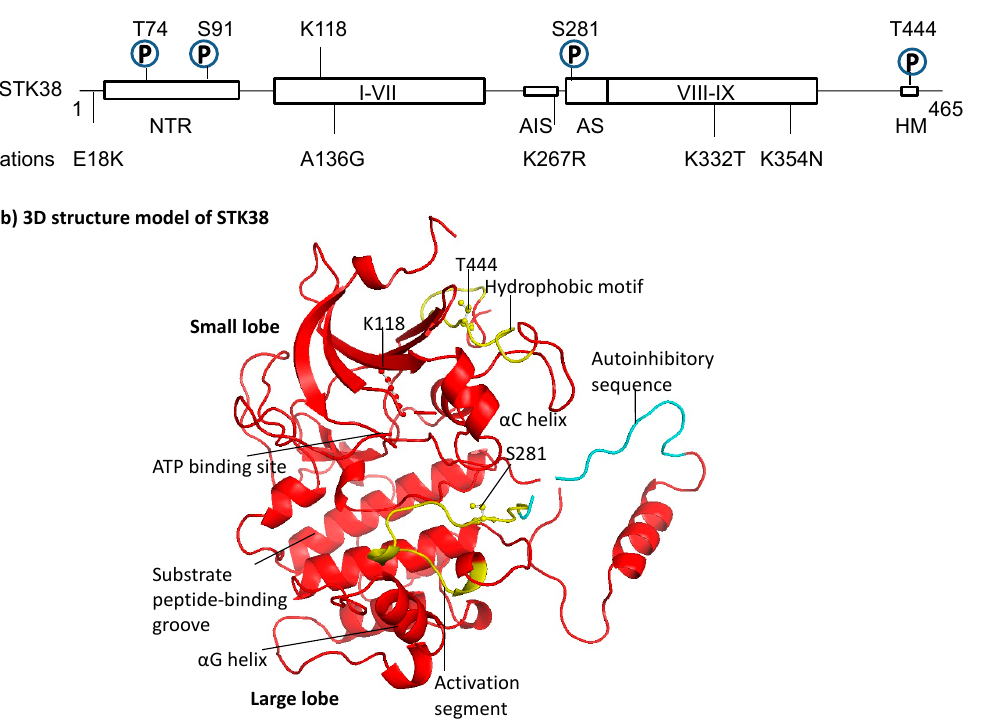
Figure 1. Most prominent three-dimensional structural features of STK38. ( a ) Domain structure of STK38. NTR at the N-terminus, subdomains I-VII, VIII-IX, activation segment (AS; aa277–292), and a hydrophobic motif (HM, aa439–451) at the C-terminus. Phosphorylation is denoted by P. The active center, a lysine residue, is located in subdomain II, and the autoinhibitory sequence (AIS, aa265–276) is situated between subdomains VII and VIII. Major somatic high-frequency mutations of STK38 in each cancer tissue are also described. Mutations in E18K are found in skin tumors, A136G in lung cancer, K332T and K354N in ovarian cancer, and K267R in normal tissues of carcinoma patients [17]. ( b ) Prediction of the domain and steric structure of STK38. Small lobe, large lobe, α C helix, and α G helix are shown in addition to the domain of a, and the three phosphorylation sites are indicated by ball-and-stick. Only the main part of the tertiary structure of STK38 is shown (Lys80-Ala456). Web site (Automated comparative protein-modeling server, Swiss Model (http://swissmodel.expasy.org/ (accessed on 31 March 2021)) was used to predict the steric structure [18–20]. 2.2. Regulation of Expression and Activity of STK38 Murine Stk38 mRNA was expressed in the spleen, lung, thymus, heart, brain, pancreas, muscle, and fatty tissue [21]. Deletion analysis and site-directed mutagenesis experiments demonstrated that Sp1 (specificity protein 1), a well-known member of a family of transcription factors which are implicated in an ample variety of essential biological processes, was required for the STK38 promoter activity [22]. Protein expression analysis revealed a high expression of STK38 in lymphoid tissues such as the thymus, spleen, and lymph nodes [17]. The subcellular localization of STK38 was originally thought to be nuclear with a nuclear localization signal (NLS)-like the sequence in the insertion sequence between subdomains VII and VIII. However, STK38 is present in the cytoplasm and the nucleus [1,23–25]. Recently, several mechanisms have been elucidated regarding the protein stability of STK38. SOCS2 (The suppressor of cytokine signaling 2) interacts with STK38 and promotes its degradation through K48-linked ubiquitination [26]. MEKK2 phosphorylates S91 of STK38, and STK38 is susceptible to degradation by the calpain pathway unless the S91 residue is phosphorylated [16]. On the other hand,